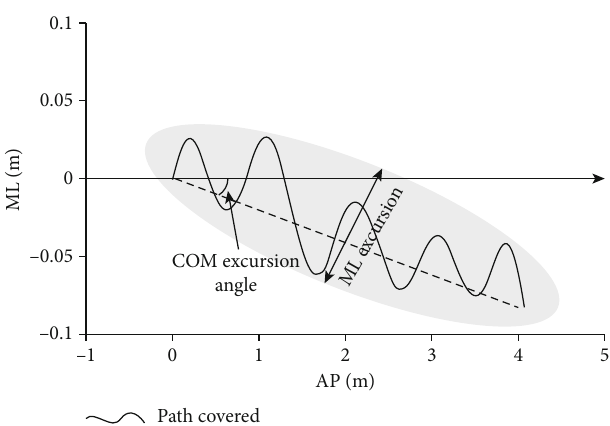
Figure 2: Graphical representation of the over-ground walkway describing how the kinematic outcome variables (COM excursion angle and ML-COM excursion) were measured in relation to the participant ’ s walking